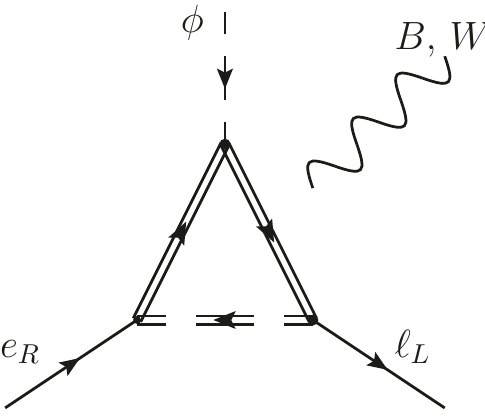
Figure 7 . Box diagram contribution to α eγ with all heavy internal propagators. Double lines represent heavy particles, whereas single lines are SM particles. The gauge boson ( B or W ) is represented outside the diagram since it can be attached to any of the internal